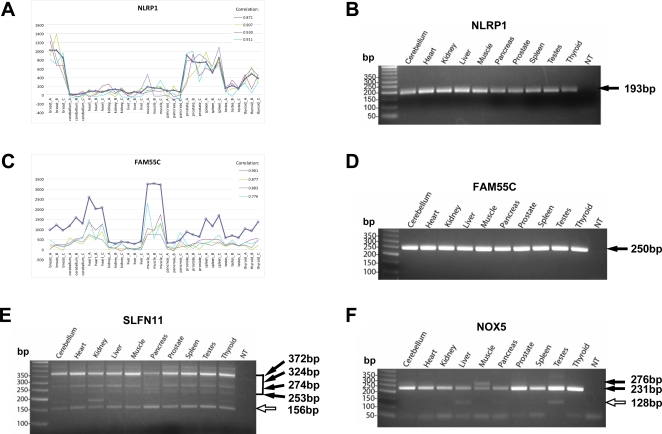
Examples of “Correlated” Exons analyzed by Exon Array analysis, semi-quantitative RT-PCR and sequencing.A. Exon array analysis of NLRP1. B. RT-PCR analysis of Alu-derived exon in NLRP1. C. Exon array analysis of FAM55C. D. RT-PCR analysis of Alu-derived exon in FAM55C. E. RT-PCR analysis of Alu-derived exon in SLFN11. F. RT-PCR analysis of Alu-derived exon in NOX5. In Exon Array analysis, the bold line represents the overall gene expression levels across all 11 tissues, each with 3 replicates; each of the fine lines represents the background corrected intensities of a probe targeting the Alu-derived exon. The Pearson correlation coefficient of the individual probe's intensities with the estimated gene expression levels in 11 tissues is shown at the top right corner of each graph. In each gel figure, solid arrows show sequencing analysis confirmed Alu exon inclusion forms. Hollow arrows show sequencing analysis confirmed Alu exon skipping forms.